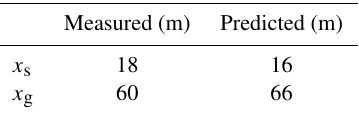
Table 3. Measured (from DEM analysis) and predicted values (from Eqs. 11 and 12) for the mean distance from divides to val- ley bottoms in shrublands ( x s ) and grasslands ( x g ).